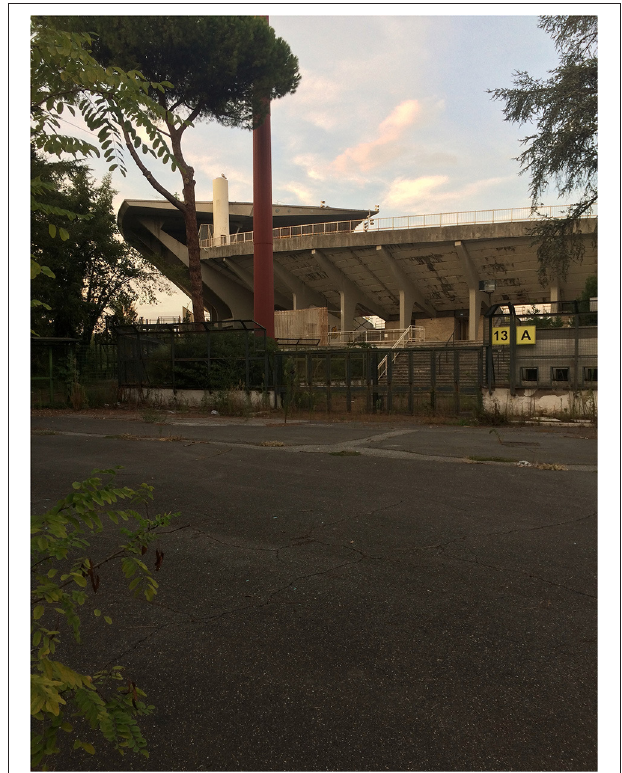
FIGURE 5 | Faded elegance: Pier Luigi Nervi’s concrete design in a state of advanced decay, September 2017 (Credit: Even Smith